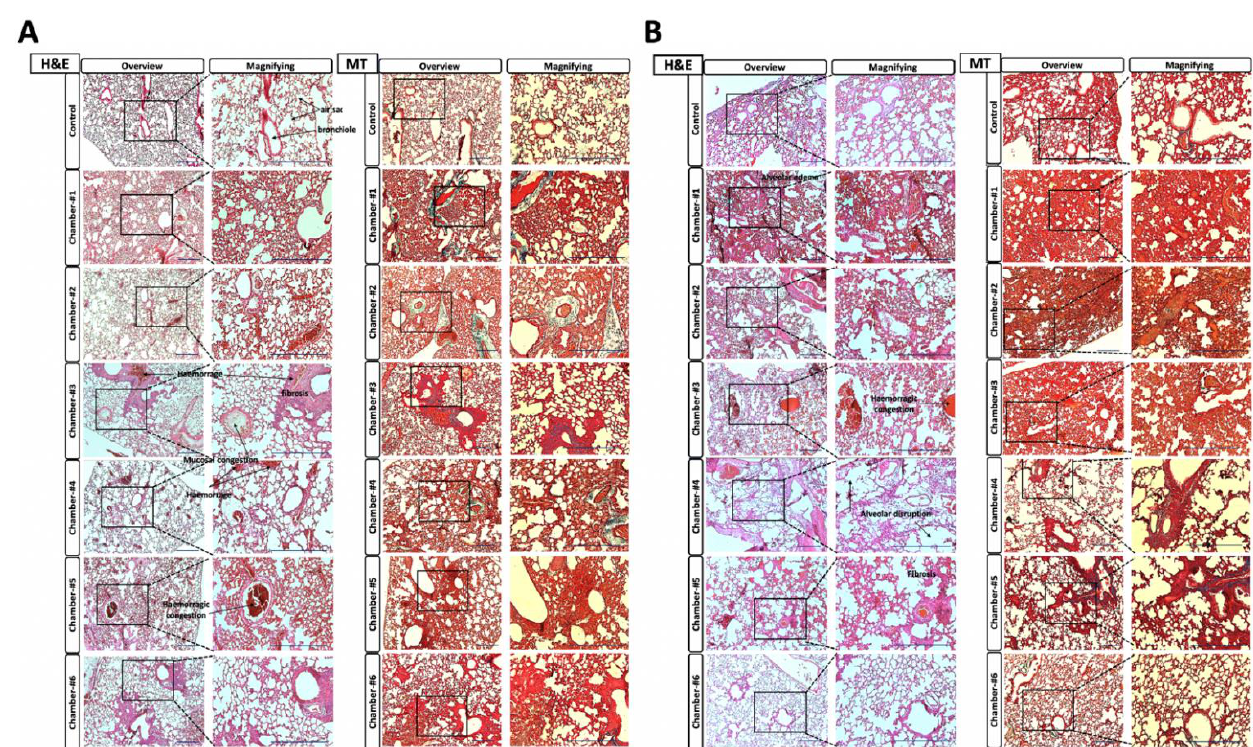
Figure 4. Lung tissue hematoxylin & eosin (H&E) and Masson’s trichrome (MT) staining results for each group. ( A ) Male histopathological staining images according to ClO 2 gas concentration. From Chamber #1 to Chamber #5, edema in alveolar cells increased fibrosis of interstitial tissue. Mucosal cohesion and thromboembolic infraction of the alveolar lumen are recognized. ( B ) Histopathologi- cal staining images of female mice by ClO 2 gas concentrations. From Chamber #1 to Chamber #5, edema in alveolar cells increased fibrosis of interstitial tissue. Findings of mucosal congestions and thromboembolic infarction in the alveolar lumen are similar to those in males. However, compared to males, alveolar lumen accounted for a higher proportion. Distraction of the alveolar wall was recognized. Black square boxes are enlarged parts of lesions. Control: non-treated group; Chamber #1: 240 ppm < group; Chamber #2: 200~240 ppm group; Chamber #3: 150~200 ppm group; Chamber #4: 100~150 ppm group; Chamber #5: 50~100 ppm group; Chamber #6: 20~50 ppm group. H&E = hematoxylin and eosin; MT = Masson’s trichrome. Scale bar = 100 µ